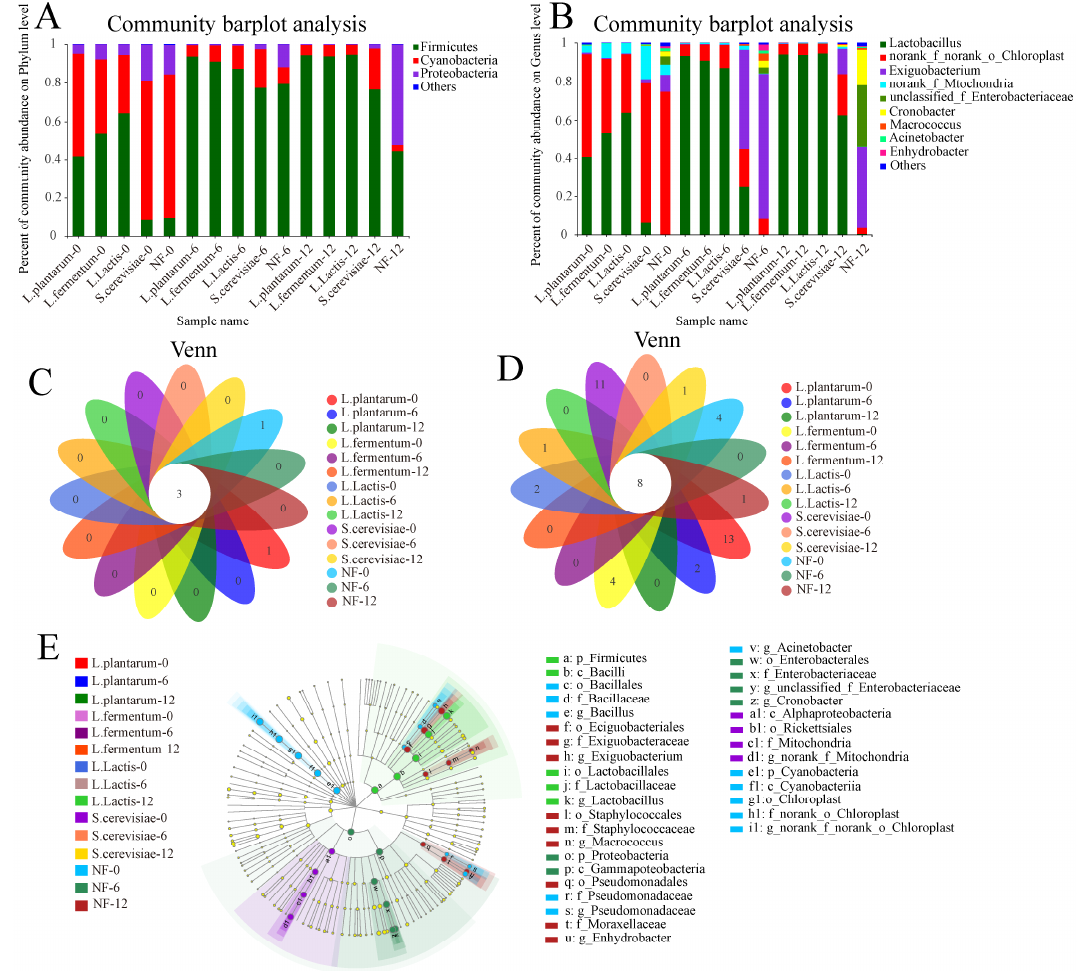
Figure 2. Changes of fresh fermented rice noodles bacterial diversity. ( A ) Relative abundance of bacterial community at the phyla level; ( B ) Relative abundance of bacterial community at the genus level; ( C ) The Veen diagram of bacterial composition the phyla level; ( D ) The Veen diagram of bacterial composition the genus level; ( E ) Linear discriminant analysis effect size (LEfSe)analysis of the bacterial composition. L. plantarum represents adding Lactobacillus plantarum ; L. fermentum represents adding Lactobacillus fermentum ; L. lactis represents adding Lactococcus lactis ; S. cerevisiae represents adding Saccharomyces cerevisiae and NF represents fermented